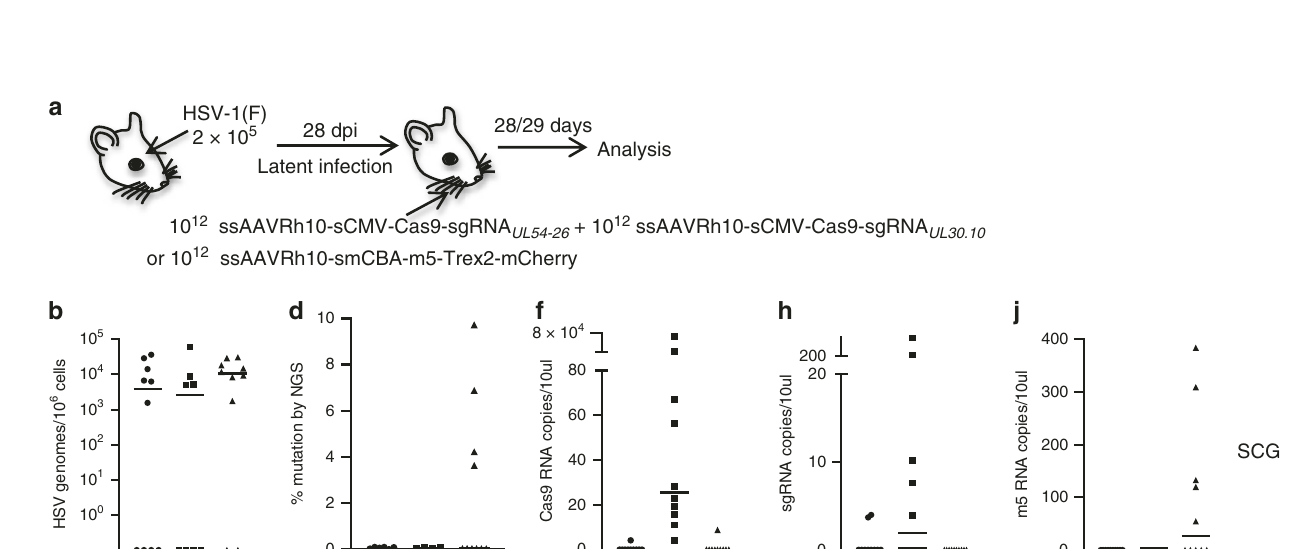
Fig. 5 Sa Cas9 gene editing of HSV in infected neuronal cultures. a Schematic of neuronal culture generation and exposure to AAV/CRISPR-Cas9 treatment. Mice were infected with 2 × 10 5 PFU of HSV-1(F); right TGs were collected 7 days later. Neuronal cultures were established, and cells were cultured for 5 days in medium supplemented with 100 μ M ACV as previously described 13 . Cells were then transduced at the indicated time at a MOI of 10 6 AAV vector genomes per neuron, with either ssAAV1-sCMV- Sa Cas9-sgRNA UL54 or ssAAV1-sCMV- Sa Cas9-sgRNA UL30 . Analysis was performed at 10 days after AAV exposure. Mutagenic event detection by T7E1 assay in DNA from cultured TG neurons treated with either b 10 6 vgs ssAAV1-sCMV- Sa Cas9-sgRNA UL54 or c ssAAV1-sCMV- Sa Cas9-sgRNA UL30 . The HSV regions containing the target site for each sgRNA were PCR ampli fi ed from total genomic DNA obtained from the right ipsilateral TG. Products were subjected to T7E1 digestion and separated on a 3% agarose gel. mw, molecular weight size ladder, V: no sgRNA, 13: sgRNA UL54-13 , 17: sgRNA UL54-17 , 26: sgRNA UL54-26 , 1: sgRNA UL30-1 , 2: sgRNA UL30-2 , 3: sgRNA UL30-3 , 6: sgRNA UL30-6 , 9: sgRNA UL30-9 , 10: sgRNA UL30-10 . Schematic representation of PCR amplicon with full-size and T7E1 cleavage product sizes indicative of HSV-speci fi c Cas9 cleavage and mutagenesis is provided below each gel. The location of the sgRNA site in the PCR product is indicated by a black (ef fi cient) or gray (inef fi cient) arrowhead, and resulting T7 digest products are indicated for ef fi cient sgRNA. d Mice were latently infected with 2 × 10 5 PFU HSV-1(F), and 28 days later were injected in the right whisker pad with 10 12 vgs ssAAV1-sCMV- Sa Cas9-sgRNA UL54 ( n = 5 per sgRNA UL54 ). Analysis was performed at either 28 ( n = 3 mice per sgRNA UL54 ) or 56 ( n = 2 mice per sgRNA UL54 ) days post AAV exposure. e Levels of HSV genomes were quanti fi ed by ddPCR in right (ipsilateral) TGs from infected mice. f Mutagenic event detection by NGS analysis of the PCR products used in the T7E1 analysis (See Supplementary Fig. 3b, c). sgRNA UL54-13 (circles), sgRNA UL54-17 (squares), and sgRNA UL54-26 (triangles). The gel images were cropped. All data are presented as mean values ± SD. bp: base pairs. Source data are provided as a Source data fi le.